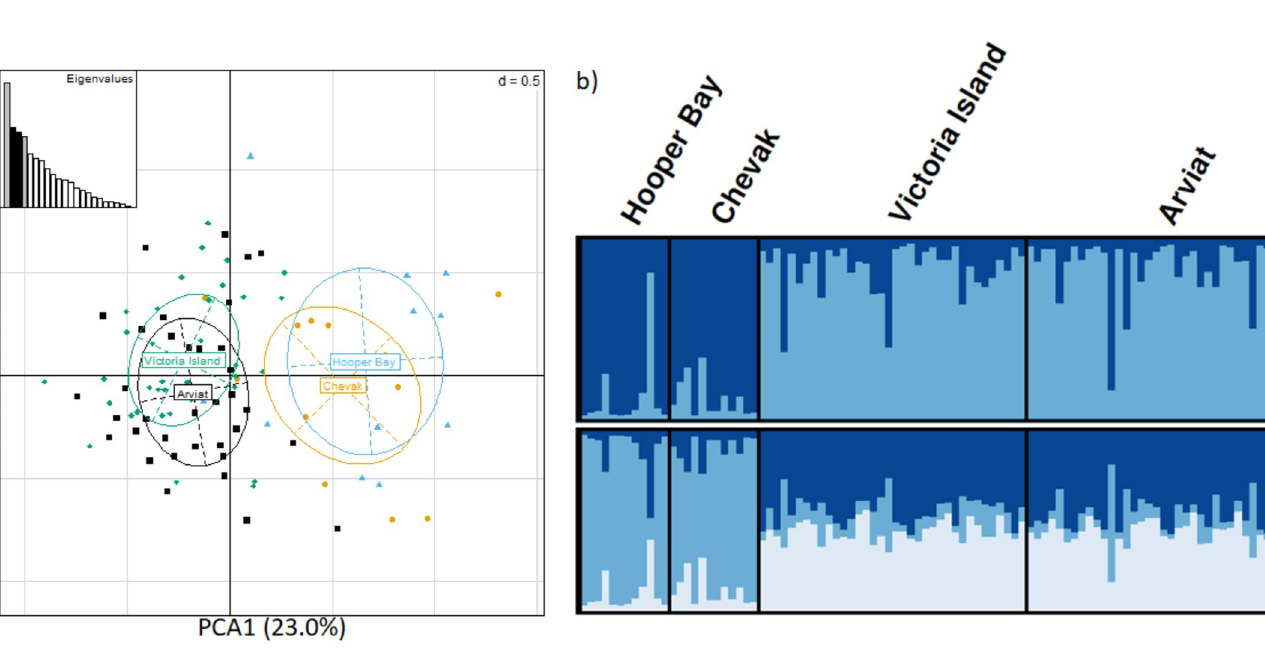
Fig 3. Arctic fox immunogenetic structure differentiates sampled regions in Southwestern Alaska and Northern Canada. Analyses of 22 protein-coding F ST outlier SNPs after filtering for MAF = 2.5% and pruning for Linkage disequilibrium A) principle component analysis and B) STRUTURE analysis of K = 2 and 3 (top and bottom respectively), where each bar across horizontal axis indicates an individual, vertical axis depicts cluster assignment, and different colors depict each genetic clusters; Arviat = black square; Chevak = yellow circle; Hooper Bay = blue triangle; Victoria Island = green diamond (note, Chevak and Hooper Bay were pooled for this